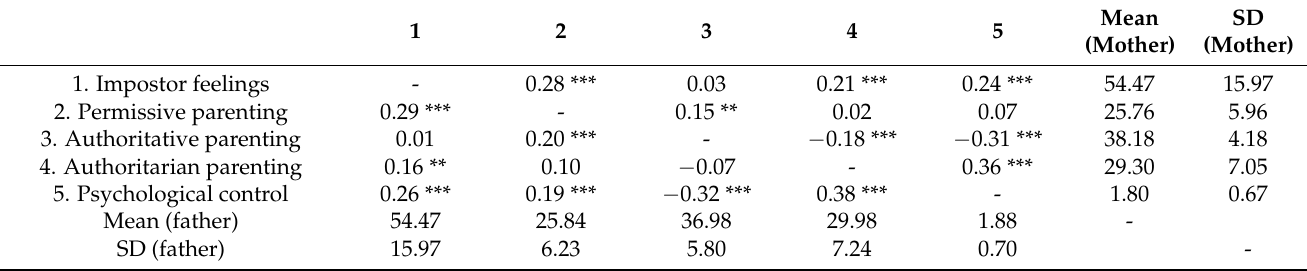
Table 1. Descriptive statistics and zero-order correlations between the study variables ( N =